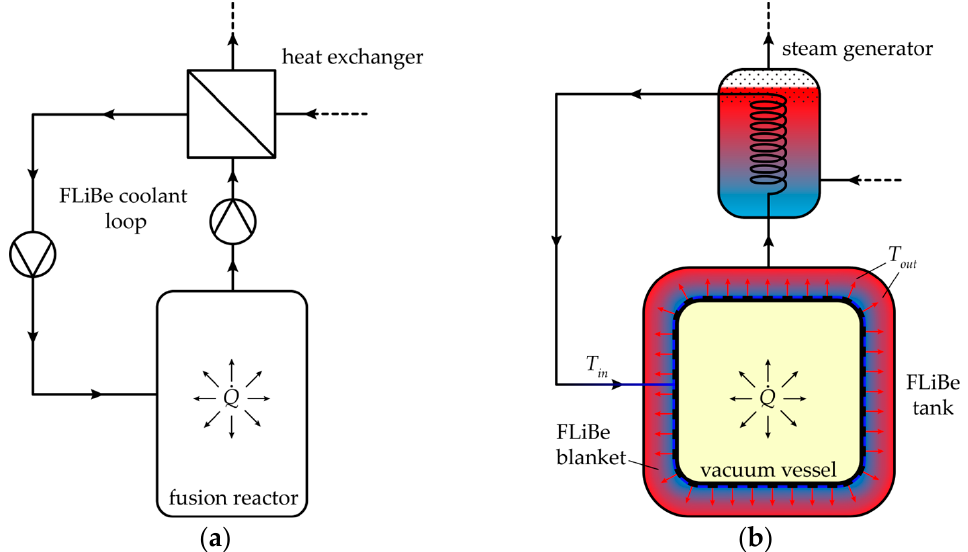
Figure 10. ( a ) Simple schematic of PEX in operation; ( b ) detailed illustration of PEX cooling the vacuum vessel.